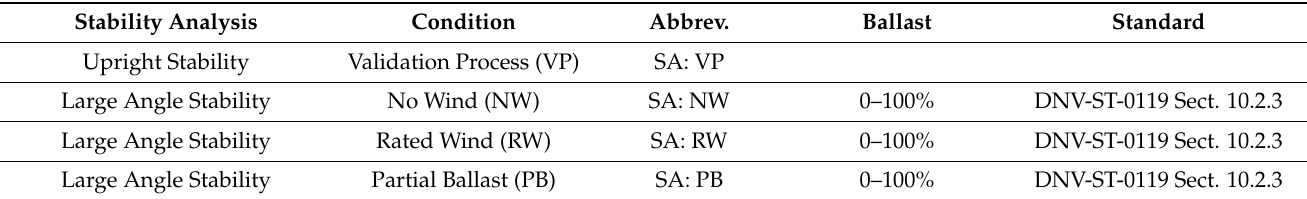
Table 4. Analysis